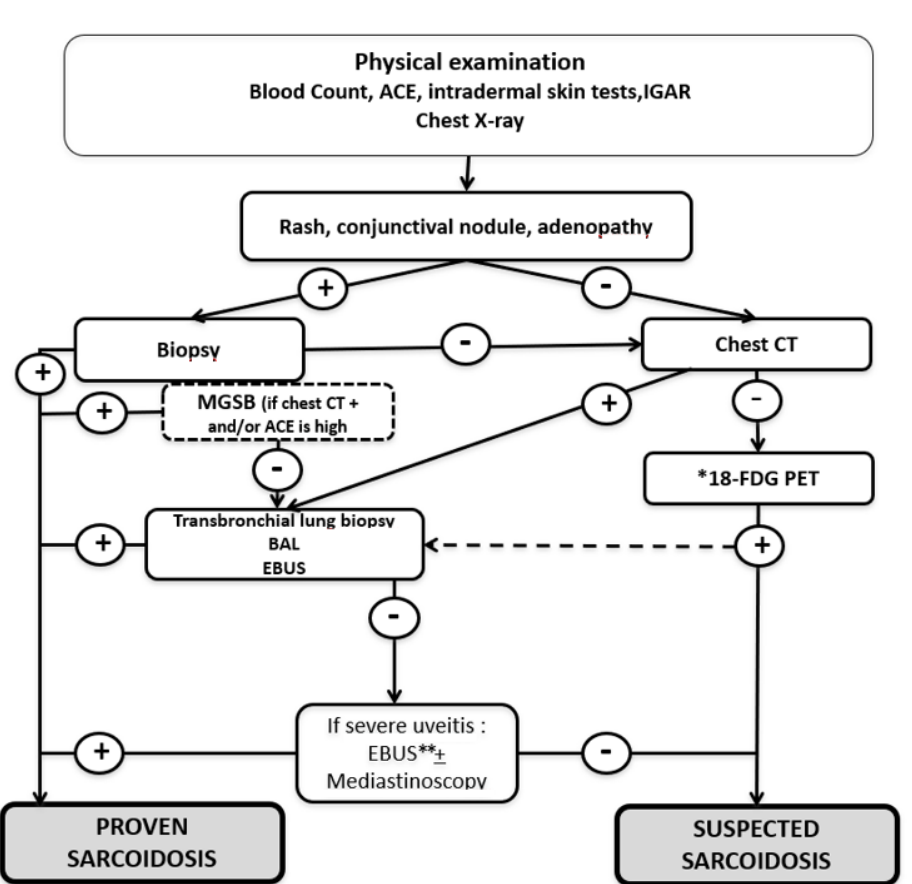
Figure 8. Algorithm to assess uveitis in patients with suspected sarcoidosis (From Sève et al., Sem